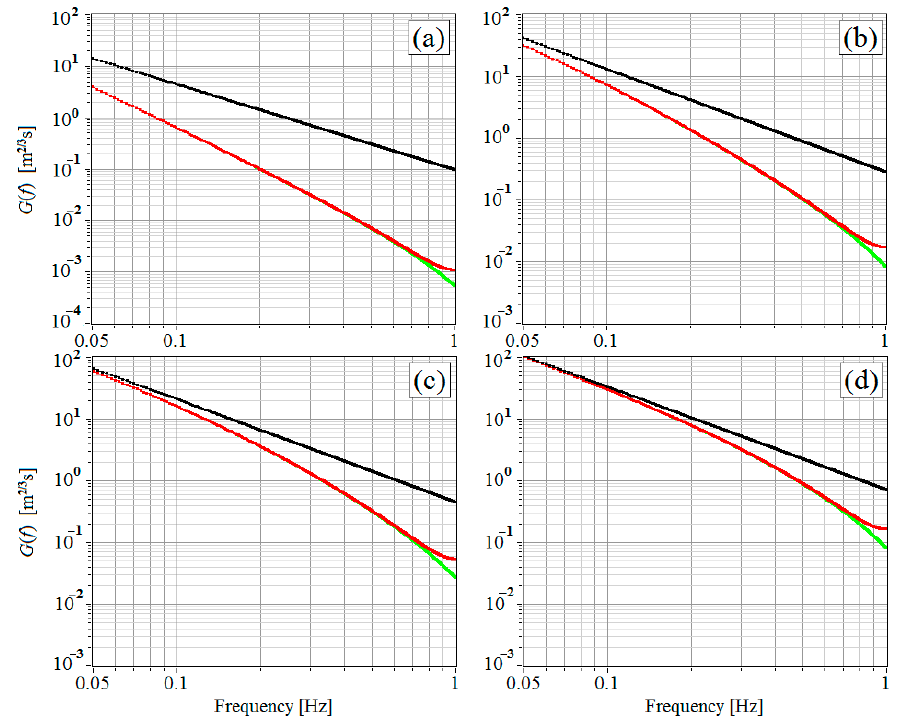
Figure 1. Fitting functions G K ( f l ) (black curves), G 1 ( f l ) (green curves), and G ( f l ) (red curves) at the mean wind velocity U = 1 m/s ( a ), 5 m/s ( b ), 10 m/s ( c ), and 20 m/s ( d ). 3/2 , where the summation is performed Using the equation ( ) / ( ) G f G f l l K l l over frequencies from 0.05 to 0.2 Hz, we calculate how many times the dissipation rate is underestimated when the effect of averaging the radial velocity over the probing volume is neglected. The results are given in Table 1. Table 1. Ratio of the estimates of the turbulence energy dissipation rate obtained with and without regard for the averaging of the radial velocity over the probing volume.